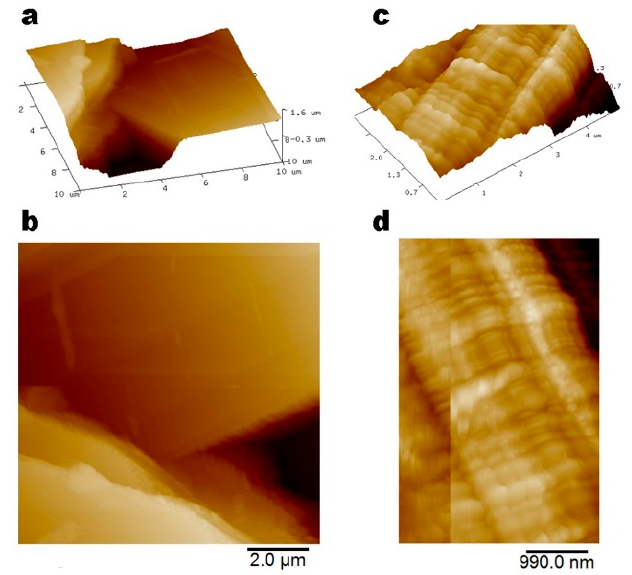
Figure 2. AFM images showing lamellar nano-structures stacked on each other in two different areas: 10 × 10 μ m ( a ) ( b ) and 4.0 × 3.4 μ m ( c ) ( d ).